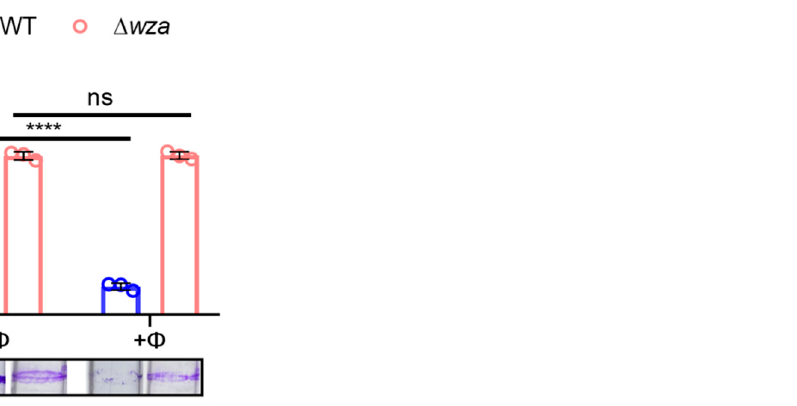
A1806. The data represent the mean ± standard deviation from triplicate experiments. **** p < 0.0001